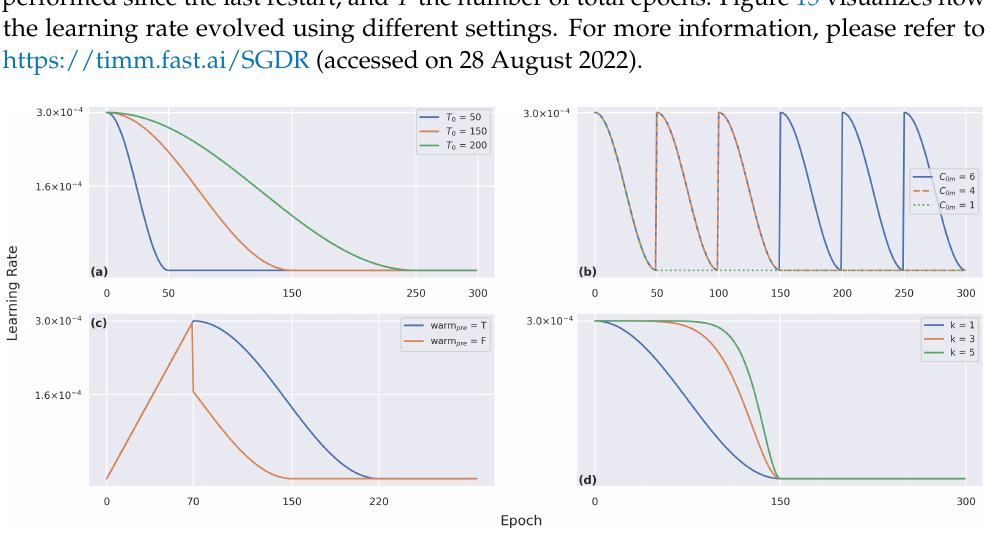
Figure 15. Visualization of the learning rate decay using the cosine annealing decay with a base learning rate of 3.0 × 10 − 4 , based on ( a ) the initial number of epochs, ( b ) the number of maximum restarts, ( c ) a warm-up of 70 epochs using a pre-fix, and ( d ) the k-decay rate from [105]. We tested VOLO-D3 with a learning rate of 1.5 × 10 − 2 by changing the settings of the cosine